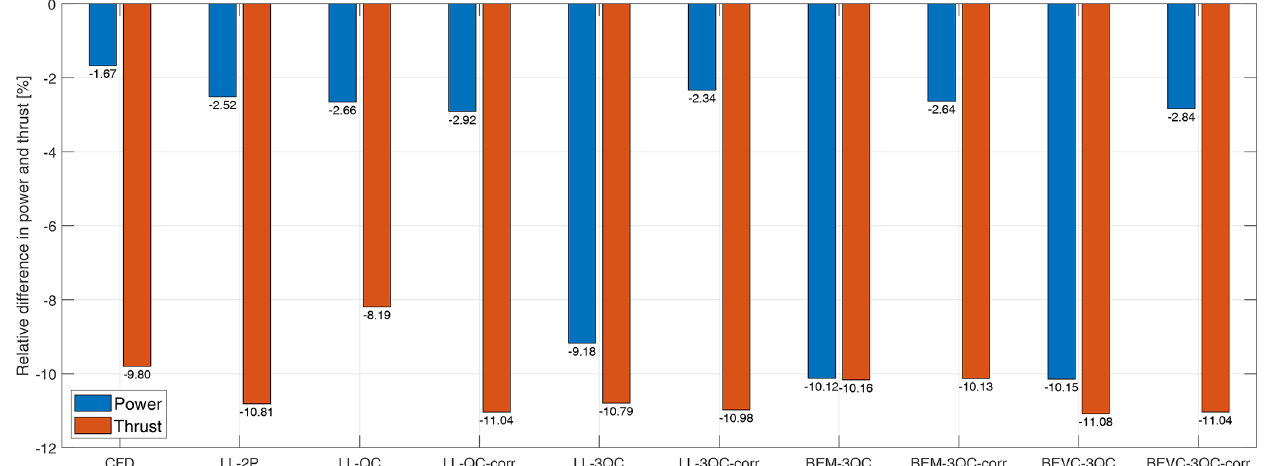
Figure 19. The relative difference in thrust and power of the rotor with straight blade with 15 ◦ of upwind coning compared to the zero-cone- angle case.